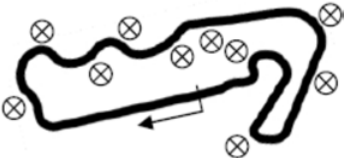
Figure 4. The curved race track driven by the par- ticipant. Markers indicate locations of the billboards, if enabled.